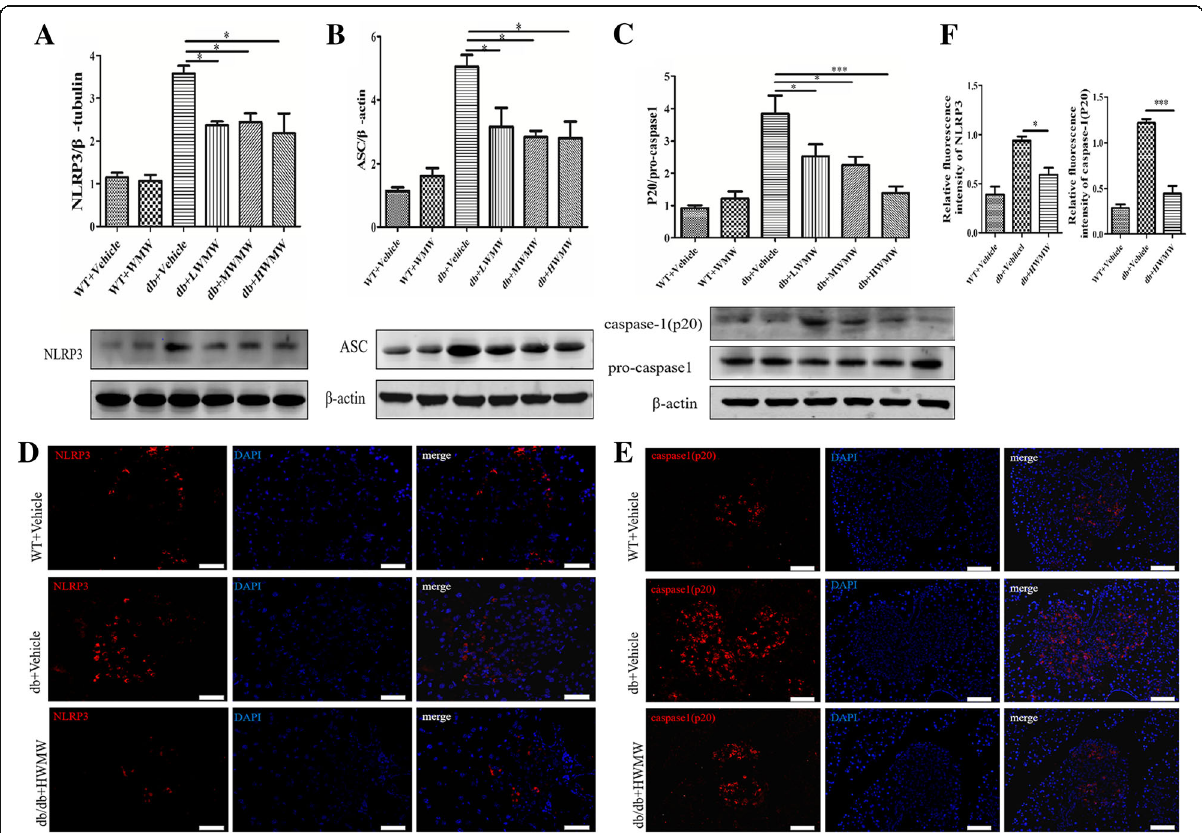
Fig. 7 Effect of WMW on the activation of the NLRP3 inflammasome in the mouse pancreas. Western blot analyses for NLRP3 ( a ); ASC ( b ); and caspase-1 (P20) ( c ). Band densities were converted to a bar graph. Immunofluorescence staining for NLRP3 (red) and caspase-1 (P20) (red) in pancreatic islets from wild-type, db/db, and db/db mice treated with HWMW (19,200 mg/kg/bw) are illustrated in ( d ) and ( e ), respectively. Nuclei were counterstained with DAPI (blue). Scales were 25 μ m ( d ) and 50 μ m ( e ). Signals for NLRP3 and caspase-1 (P20) were calculated in bar graph ( f ). P < 0.05 (*), P < 0.001 (***) ( n =